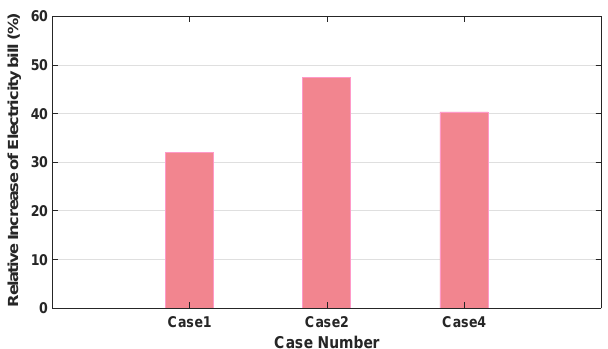
Figure 8. Comparison of a relative increase of the total electricity bill in Case 3 among the considered three cases.